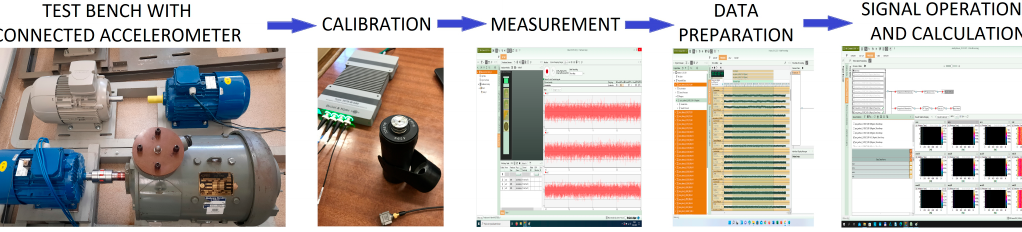
Figure 5. Flowchart of the vibration measurement.